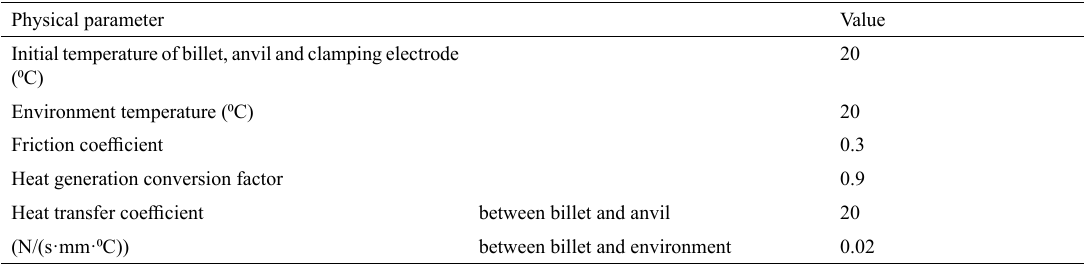
Table 3: Original processing parameters of the electric upsetting